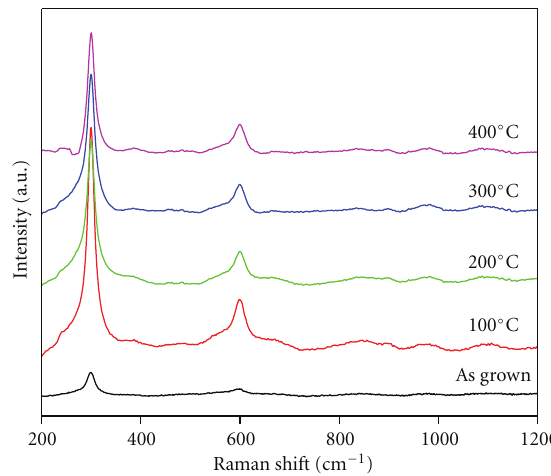
Figure 2: Raman spectra of as grown and annealed, Ag-doped nanostructured CdS thin films prepared by cost-e ff ective chemical route at room temperature.